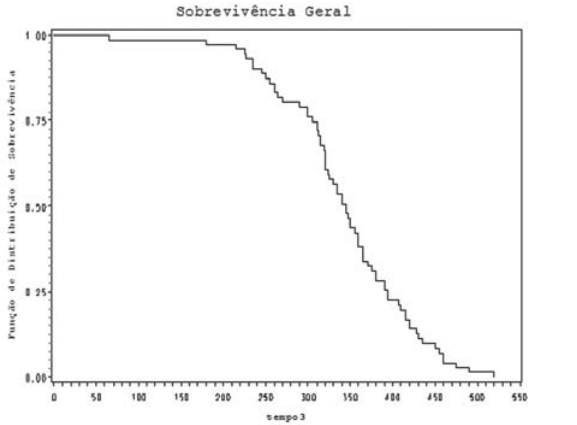
Fig. 3 - Sobrevivência Geral - tempo 3; T3 - Tempo da Presença do Doente na Sala de Operação (minutos)